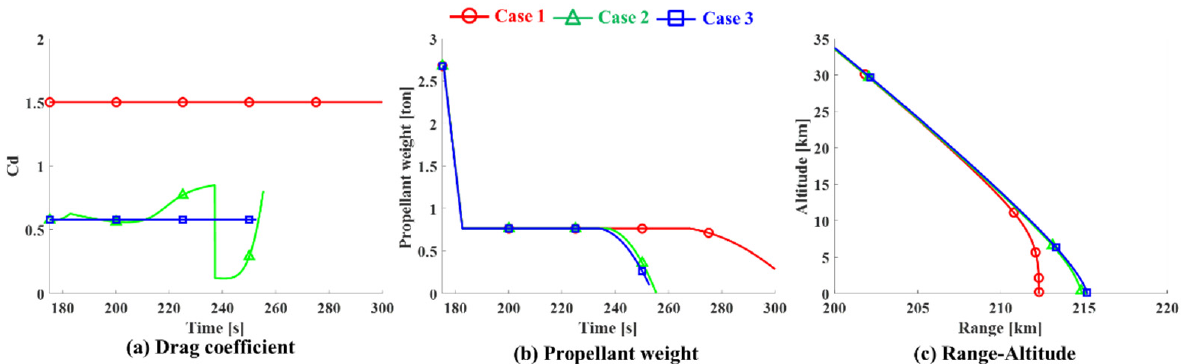
Figure 23. Trajectory results according to cases of the drag coefficient (Case 1: General constant value, Case 2: Function from CFD results, Case 3: Constant value averaged from calculation result with function). ( a ) Drag coefficient; ( b ) Propellant weight; ( c )